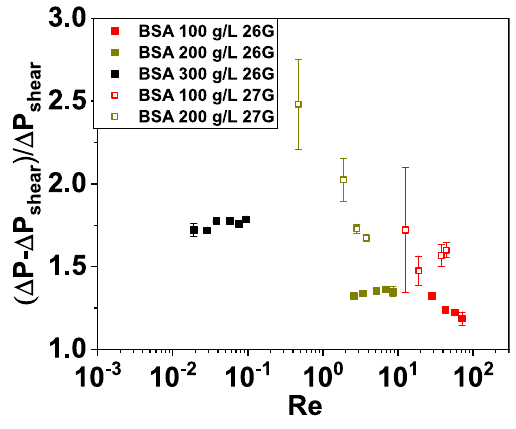
Fig. 8 The non-dimensionalized extra pressure drop 𝛥 P � = 𝛥 P − 𝛥 P shear plotted as a function of Re for the flow of the BSA solutions through the “26-G” and the “27-G”